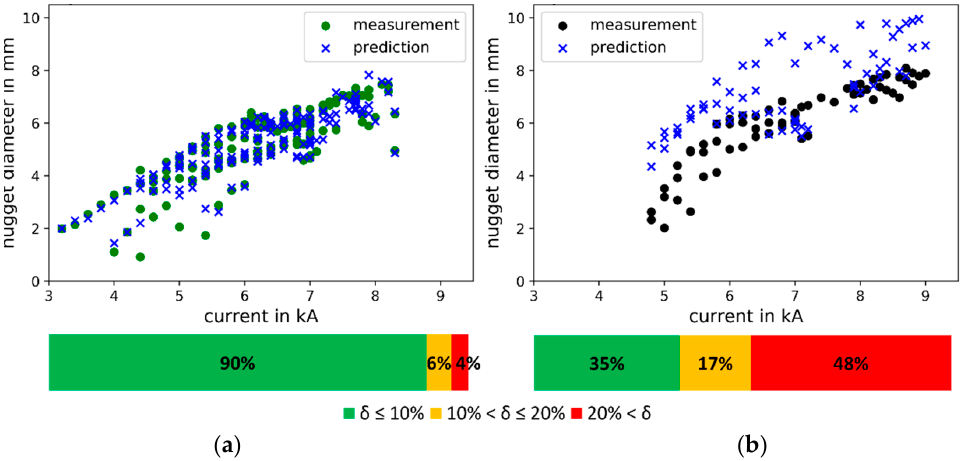
Figure 7. Predictive performance of the third model. The training included the dynamic resistance features extracted by ‘TSFRESH’: ( a ) scatter plot of the measured and predicted nugget diameters from dataset 1; ( b ) scatter plot of the measured and predicted nugget diameters from dataset 2. The bar charts show the predictive accuracy based on the prescribed deviation.